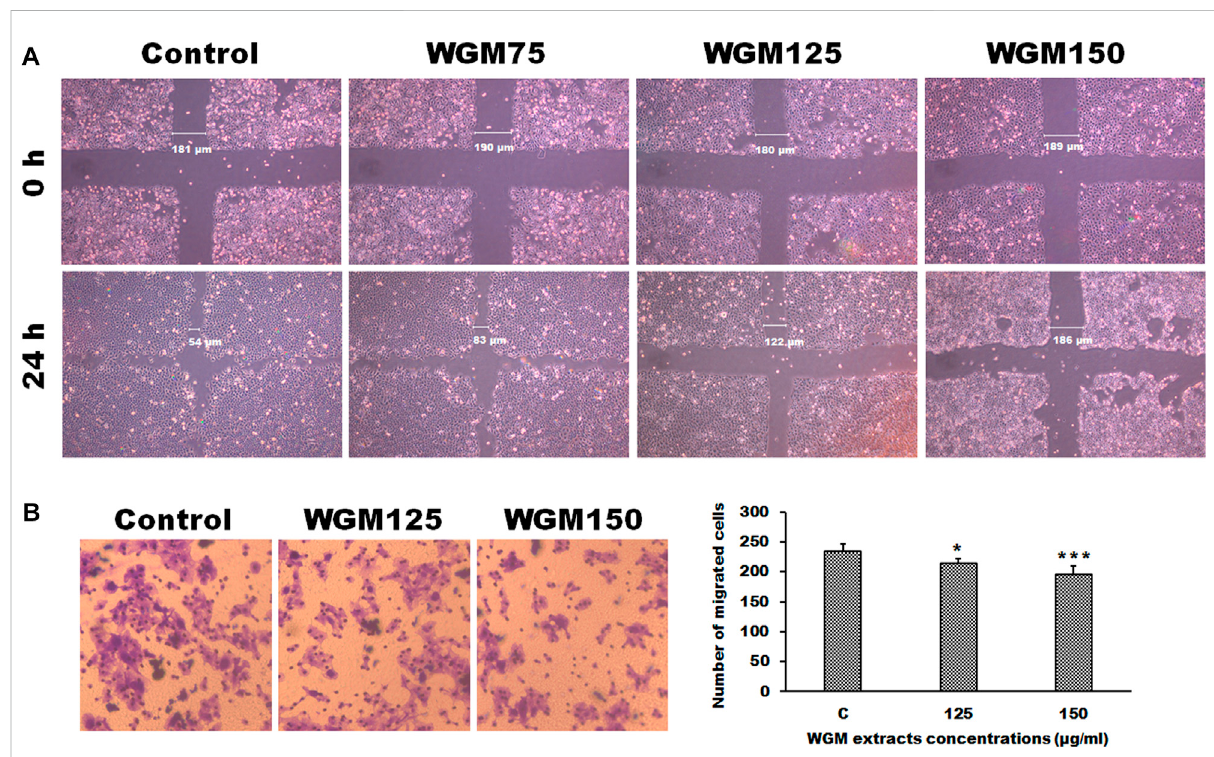
FIGURE 9 The effect of WGM extracts on cell migration of Hep3B cells. (A) The migratory activity ofHep3Bcells was assessedusing awounded migration assay. A linear wound was made with a sterile 200 μ l pipette tip. Cells were treated with vehicle alone (Control) or with 75, 125 or 150 μ g/ml WGM extracts for 24 h. Images of wounds at 0 h and 24 h after scratching were obtained with an Olympus IX 73 phase-contrast microscope at objective ×10 magni fi cation. All results are representative of three independent experiments. (B) The effects of WGM extracts on cell migration of Hep3B cells were also measured by Transwell assay in the study. Cell migration was also detected using Transwell assay with a pore size of 8 μ m the Transwell inserts for 24-well plates. Cells were treated with vehicle alone or with 125 or 150 μ g/ml WGM extracts for 24 h. Filters were fi xed with 4% paraformaldehyde solution for 20 min and stained with 0.1% crystal violet for 10 min, then the cells that passed through the fi lter were photographed by Olympus IX 73 phase-contrast microscope at objective ×20 magni fi cation. Left: Representative images of Transwell migration assay. Right: Cells were counted from 4 random microscope fi elds for each sample in three independent experiments. Results are expressed as the mean ± S.D. * p < 0.05, *** p < 0.001 compared to the control